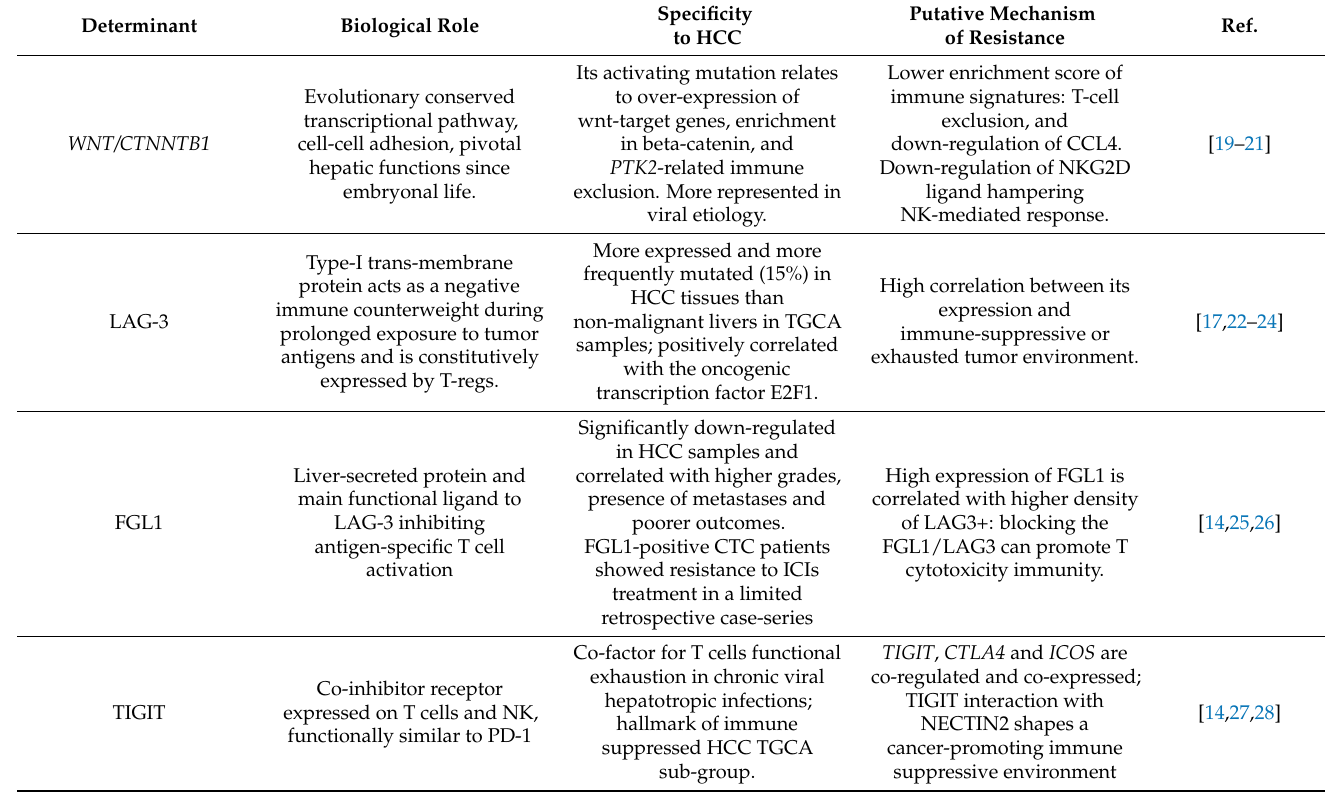
Table 1. Most-studied determinants of ICIs resistance in